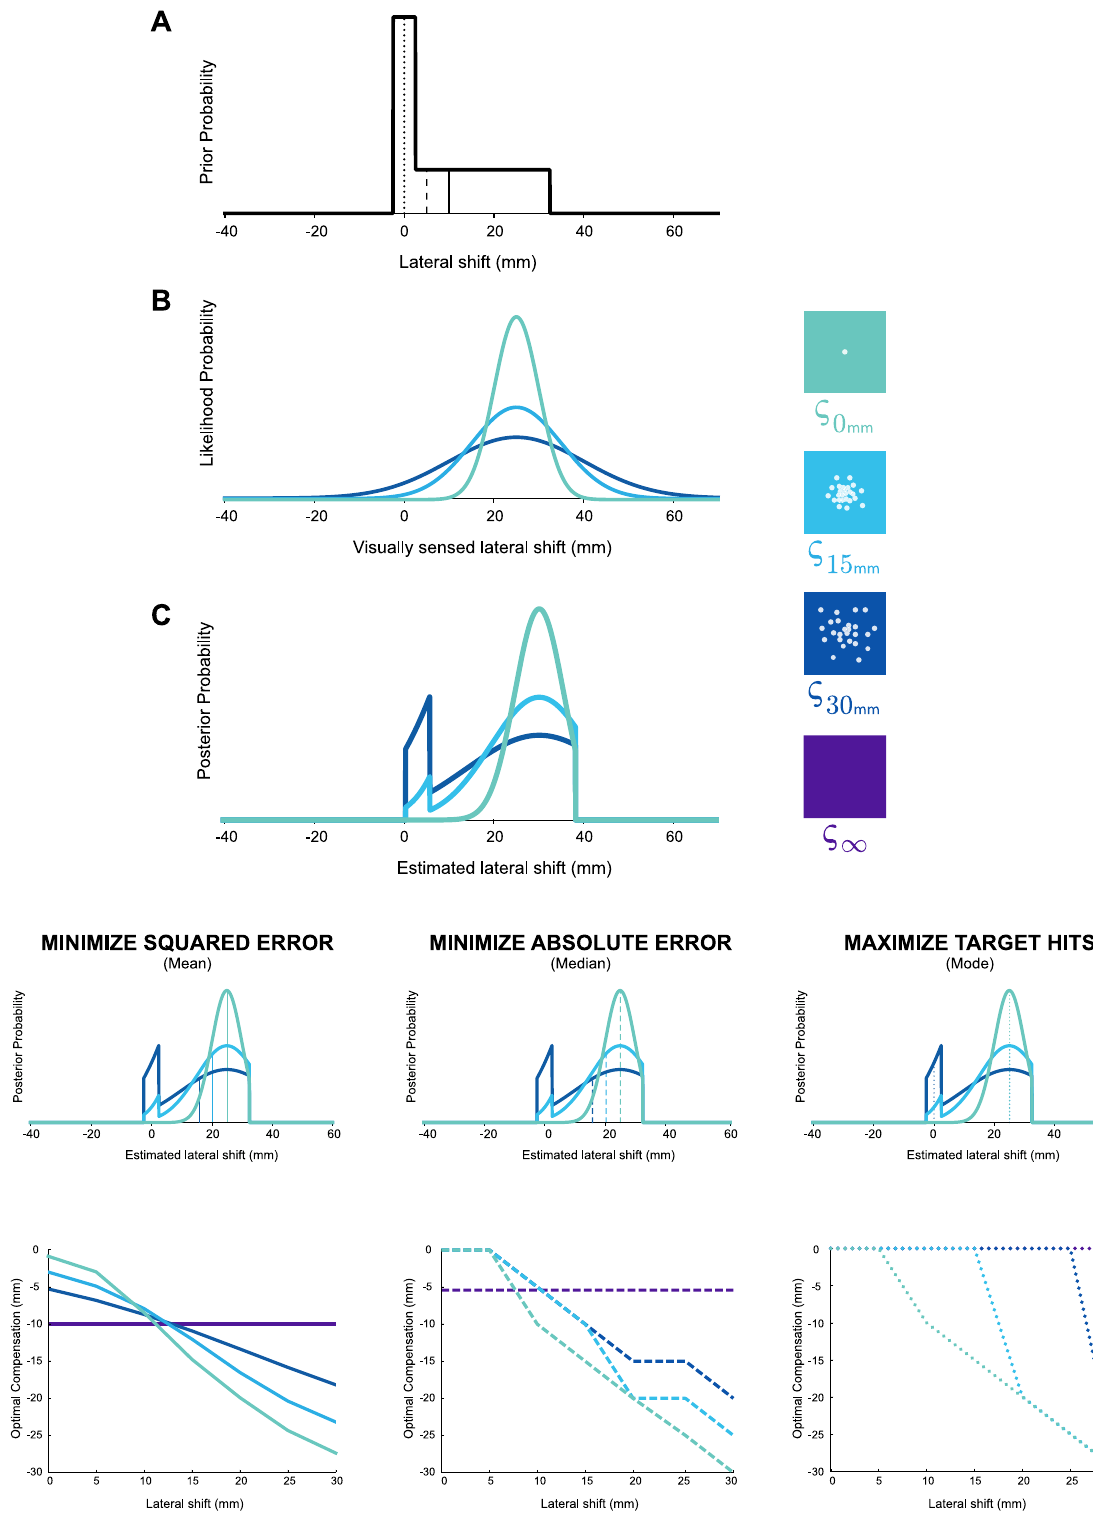
Fig 2. Experiment 1 : By multiplying A) the probabilityof a lateral shift (prior probability) with B) the visuallysensed lateral shift (likelihood probability) we obtain C) an estimate of the lateral shift (posteriorprobability)given current evidenceand previous experience. The different colors in B-E representthe different amounts of visual uncertainty ( ς 0 mm = singledot; ς 15 mm = medium cloud of dots; ς 30 mm = large cloud of dots; or ς 1 = feedbackwithheld). For a lateral shift of 22.5 mm , D) shows the optimalcompensationfor three different loss functions that either: i) minimizesquarederror, ii) minimizeabsoluteerror, or iii) maximizetarget hits, which is found by taking the mean (solid vertical line),